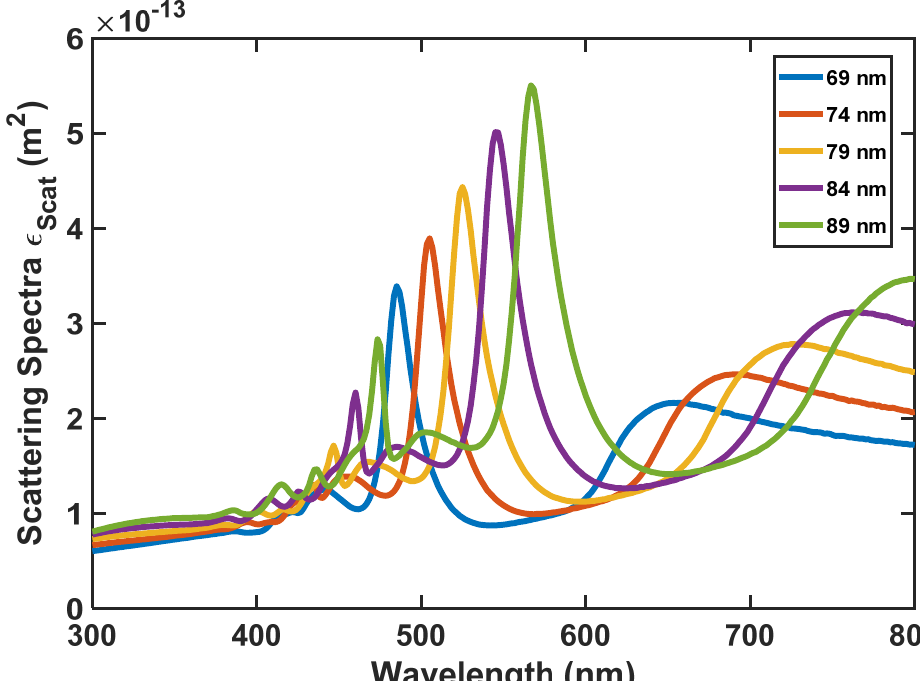
Figure 10. SiO 2 /Si nanoparticle’s absorption spectra for its different radii.